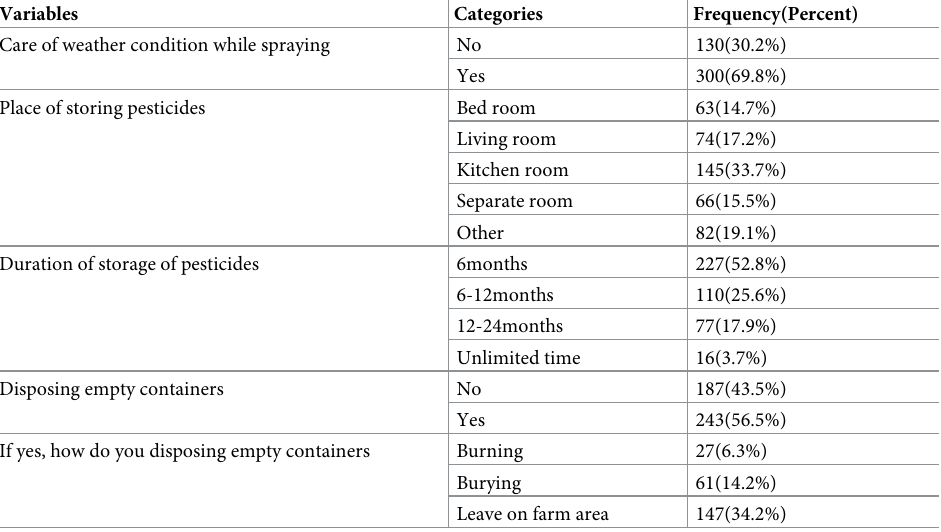
Table 4. Environmental factors on safety practices of pesticides use in Fogera district among farmers of wetland areas, Northwest